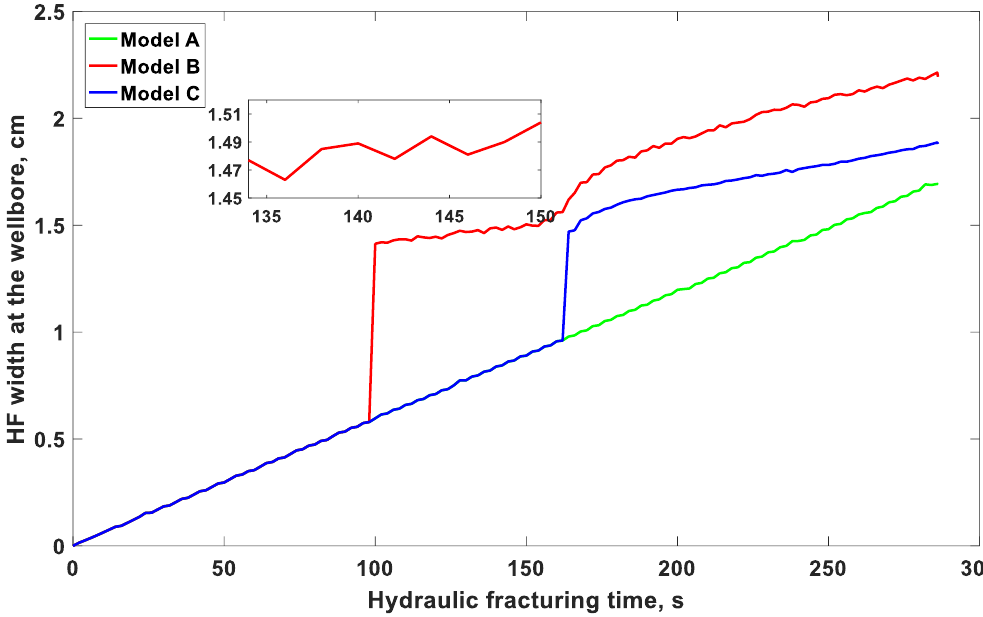
Figure 4—Evolution of the HF width at the wellbore in the three